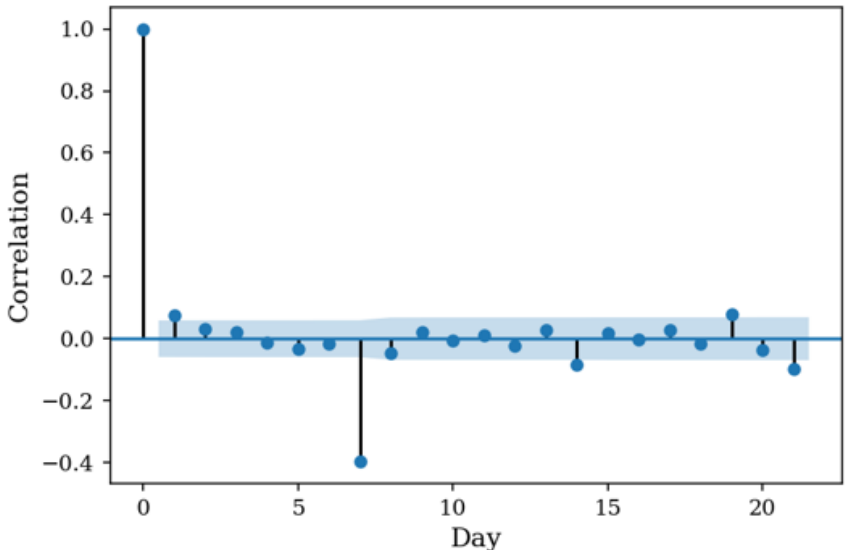
Figure 7. Weekly Differenced Correlation Plot. Differencing weekly has removed most correlation between the days. Every seven days does give some negative correlation, but it quickly falls within the confidence threshold.